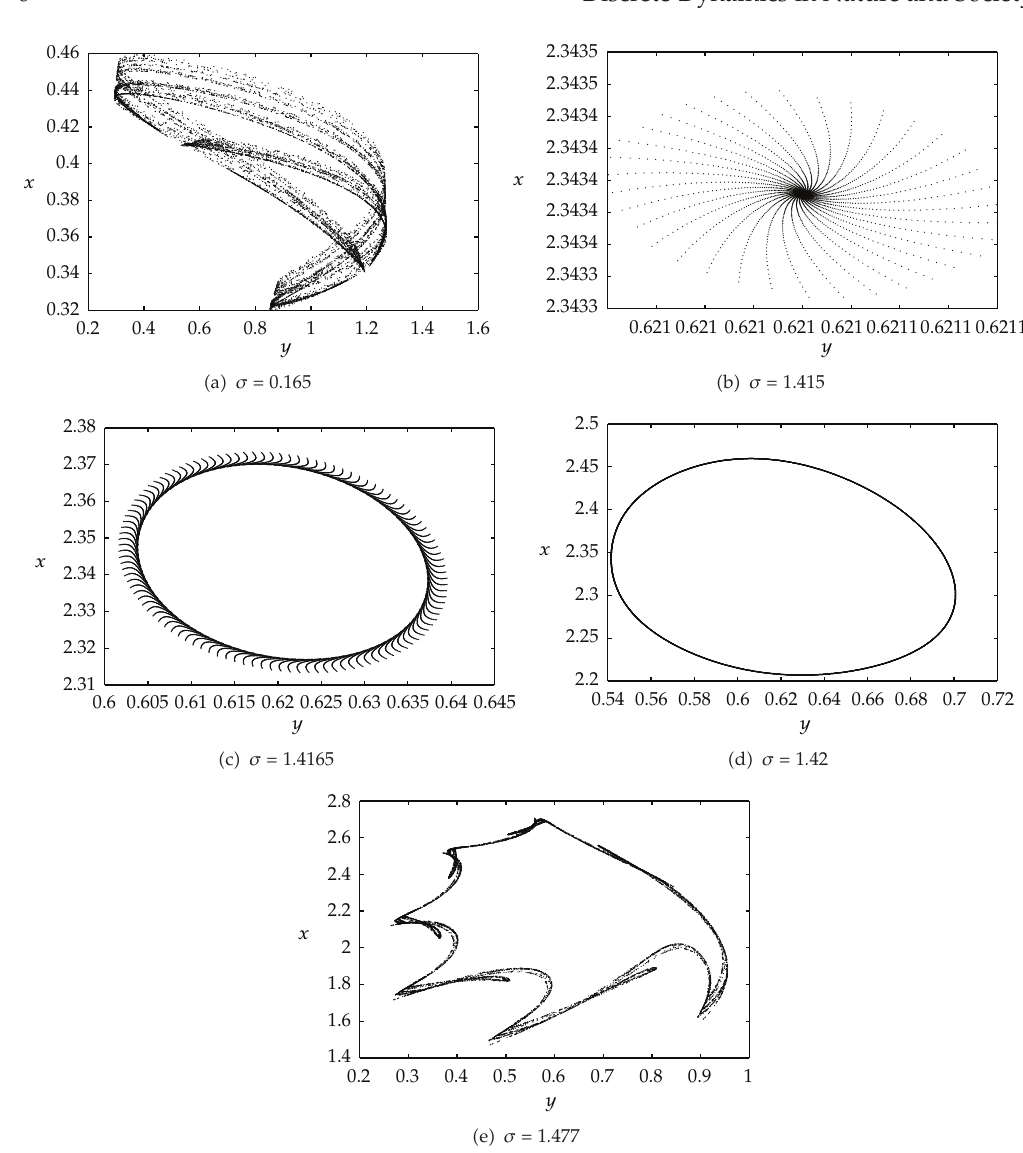
Figure 3: Phase plot with the parameters of Figure 1. (cid:2) a (cid:3) chaotic trajectory; (cid:2) b (cid:3) the stable fixed point before the Neimark-Sacker bifurcation occurs; (cid:2) c (cid:3) the Neimark-Sacker bifurcation; (cid:2) d (cid:3) the stable invariant closed curve around the fixed point created after bifurcation; (cid:2) e (cid:3) chaotic trajectory.